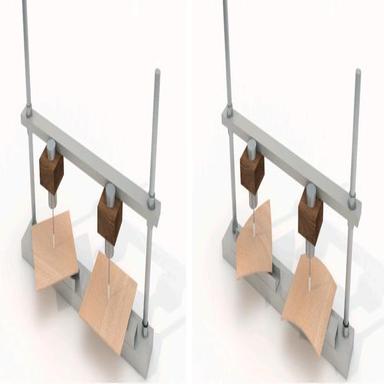
3D simulation showing the functioning of the measurement support with the panels in a flat condition (left) and after the exposure to humidity (right).